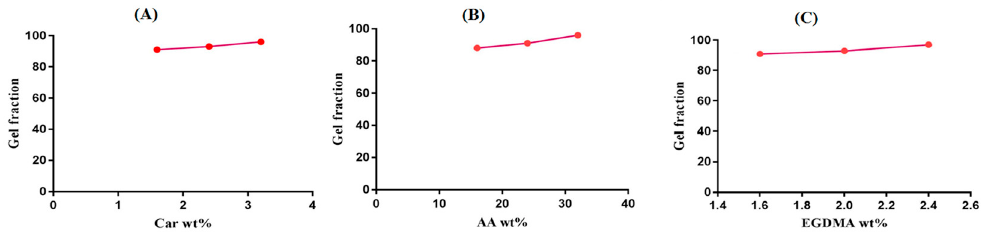
Figure 7. Effects of ( A ) carbopol, ( B ) AA and ( C ) EGDMA on the gel fractions of the Car934-g-poly(acrylic acid) hydrogels.